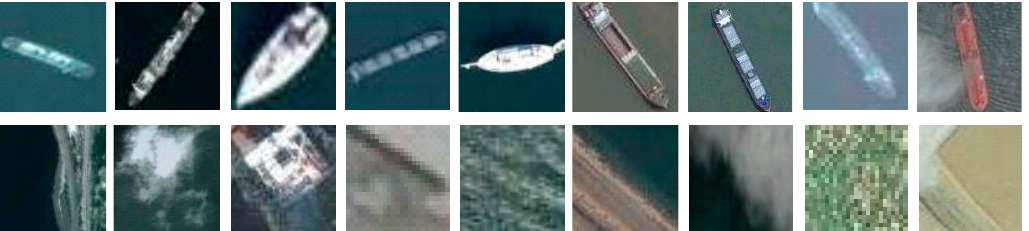
Figure 12. Examples of the candidate regions. The real ship targets are presented in the first row. The false alarms are presented in the second row.